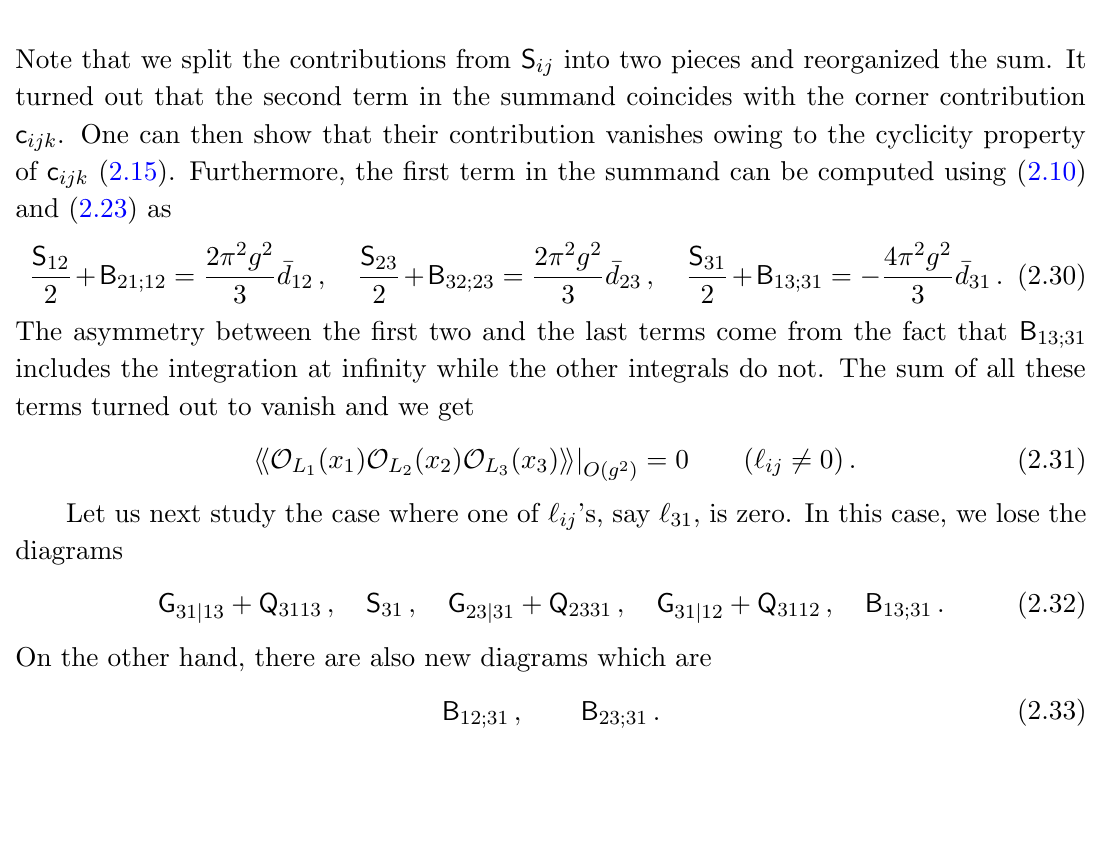
Figure 8 . The one-loop corrections to the three-point function with L 1 = L 2 = L 3 = 2. The (cid:12)rst line and the second line denote the contributions from G and Q ijjk respectively while the ij j jk third line denotes the contribution from the boundary diagrams B jk ; kj . The last line denotes the contribution from the self-energy diagrams. The diagrams add up to